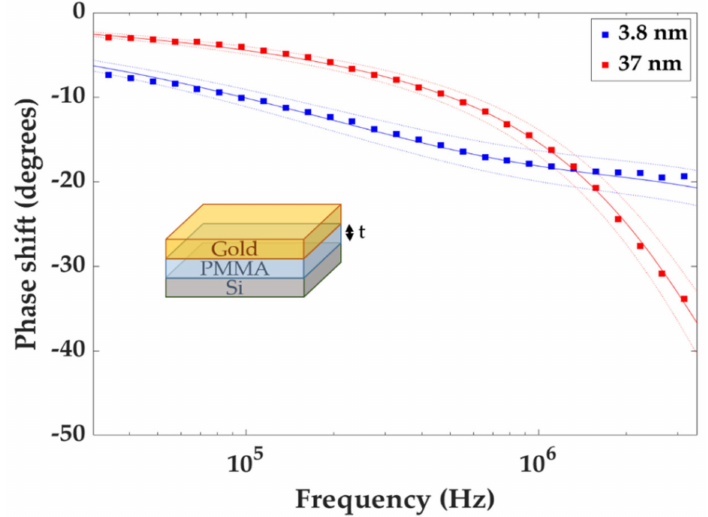
Figure 2. Phase shift is plot as a function of modulation frequency of the pump laser for Au / PMMA / Si (APS) samples with PMMA layer thicknesses 3.8 nm and 37 nm, respectively. The experimental data is then fitted to the thermal model, and the best fit is given as the solid curves using κ eff as the fit parameter. In this particular case, for the 3.8 nm PMMA, κ eff = 0.1160 W · m − 1 · K − 1 with 1.64% fit error, and the 37 nm PMMA the κ eff = 0.1890 W · m − 1 · K − 1 with 0.20% fit error. The dotted curves above and below the solid curve correspond to best fit for the κ eff ± 10%